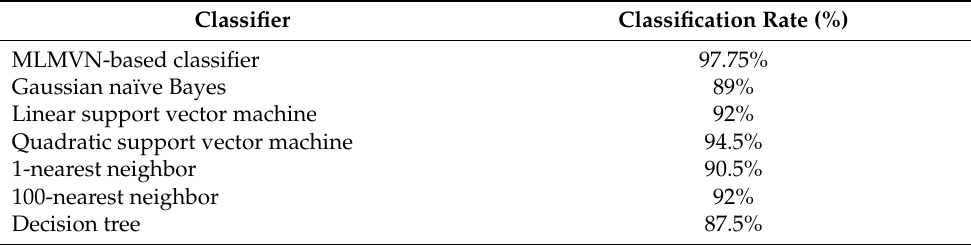
Table 7. Comparison with other machine learning